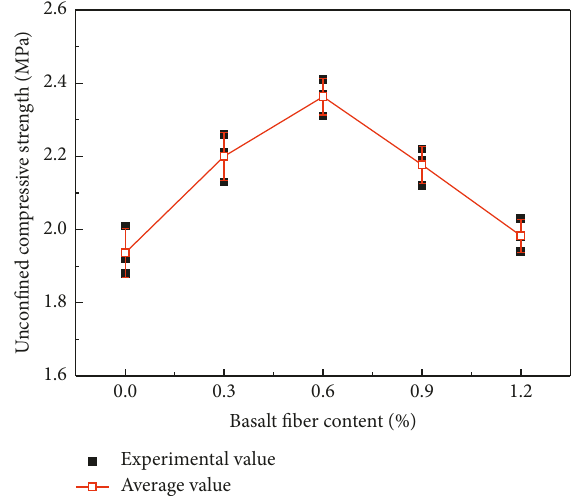
Figure 11: Unconfined compressive strength of basalt fiber- reinforced cement-fly ash-stabilized